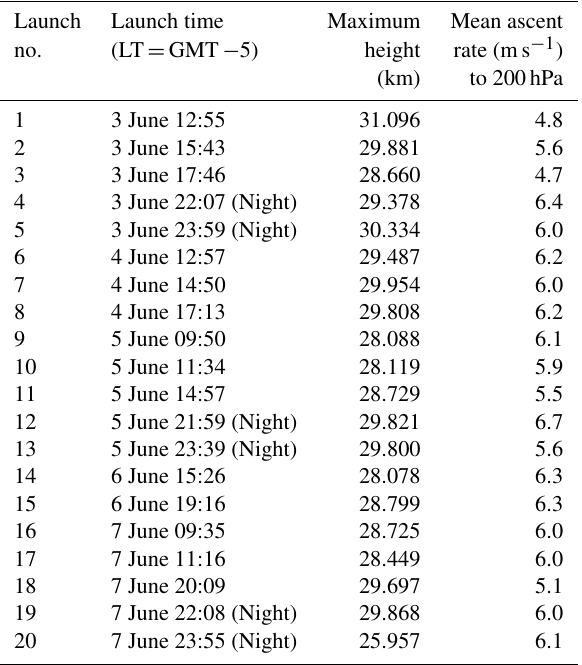
Figure 5. Time series of surface-based meteorological observa- tions: (a) precipitable water vapor (PWV) retrieved from a two- channel microwave radiometer, (b) surface temperature (blue) and relative humidity (green), and (c) hemispheric sky cover as observed by a total sky imager (TSI). Vertical black lines represent the times of radiosonde